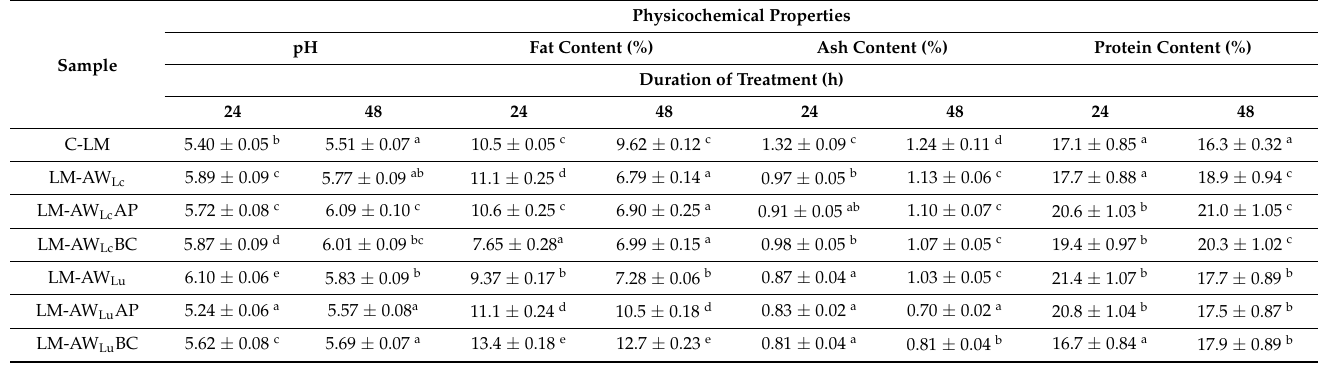
Table 5. The chemical composition of the lamb meat samples treated with the different